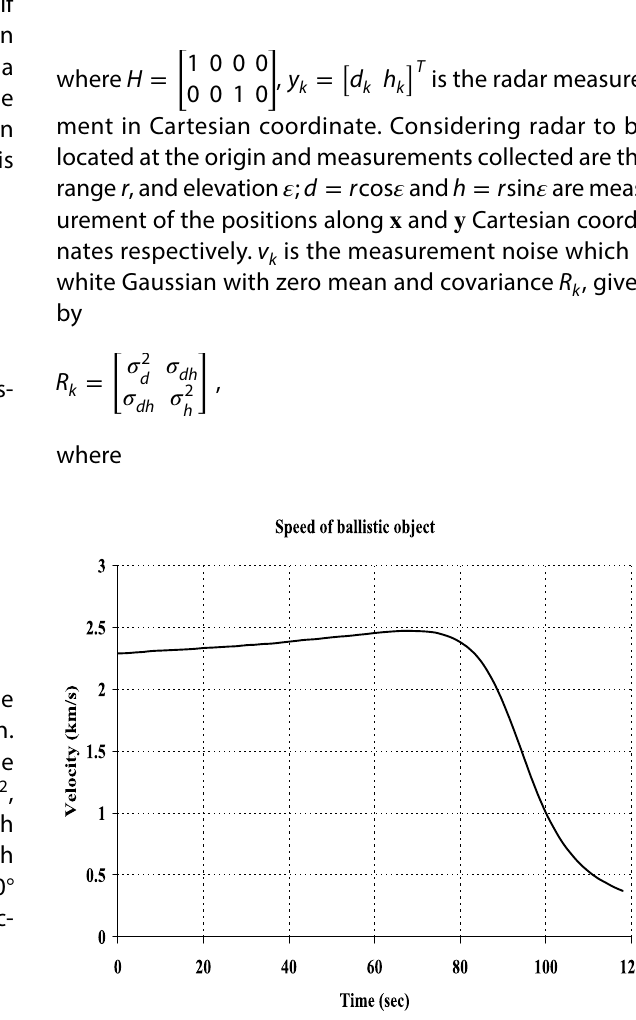
Fig. 1 Target trajectory of ballistic target